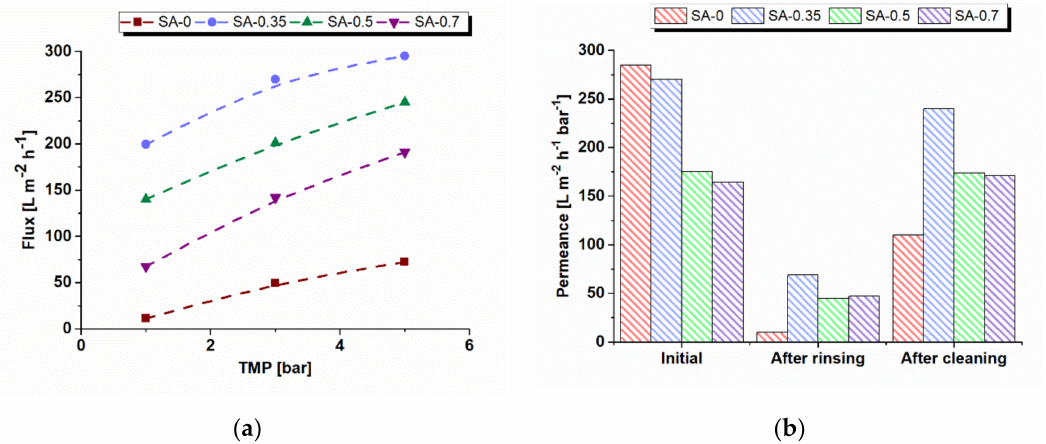
Figure 11. ( a ) Dependence of flux of ThMP process water of the reference and modified membranes on transmembrane pressure (TMP); ( b ) changes in pure water permeance correlated to the PAA concentration and chemical cleaning results for reference and modified